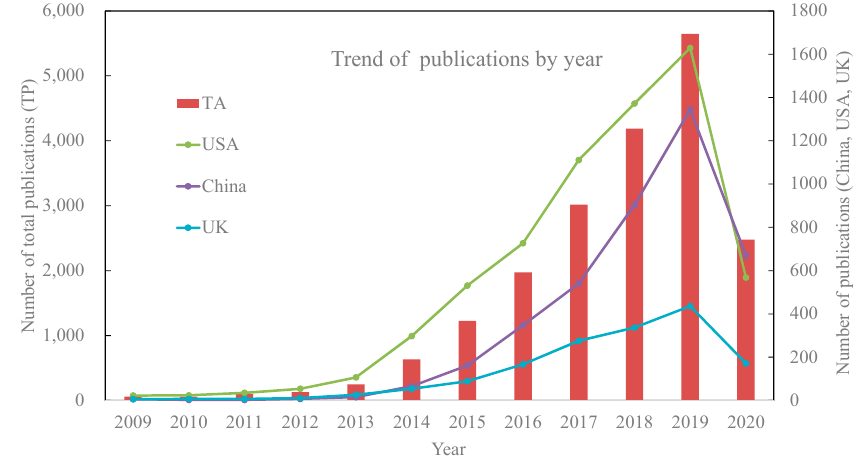
Figure 1. Trends in the number of publications (all types) related to 3D printing by year.